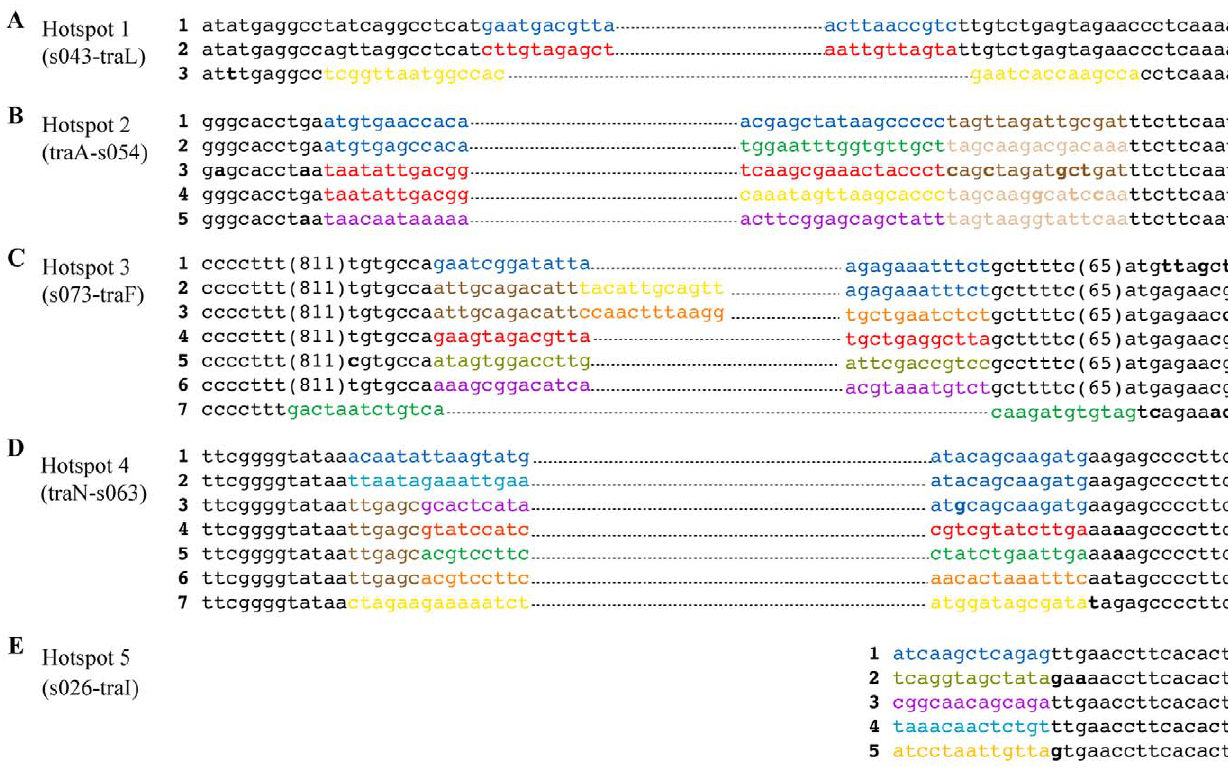
Figure 3. The boundaries of the 5 hotspots. The boundaries between conserved and hotspot variable regions are shown. Black typeface indicates conserved sequence, while color indicates variable sequence. Numbers in parentheses indicate the number of intervening nucleotides. The thin dotted lines indicate continuations of variable DNA. Bold letters indicate a non-conserved base. (A) Hotspot 1, which is present between traJ and traL . Line 1: SXT, ICE Vch Ind4, ICE Pal Ban1; Line 2: R391, ICE Pda Spa1, ICE Vch Ban5, ICE Vch Ind5, ICE Pmi USA, ICE Spu PO1, ICE Vfl Ind, ICE Vch Moz10, ICE Vch Ban9; Line 3: ICE Vch Mex1. (B) Hotspot 2, which is present between traA and s054 . Line 1: SXT, ICE Vch Ind4, ICE Pmi USA, ICE Vfl Ind, ICE Vch Ind5, ICE Pal Ban1, ICE Vch Ban5; Line 2: ICE Pda Spa1, ICE Vch Moz10, ICE Vch Ban9; Line 3: R391; Line 4: ICE Vch Mex1; Line 5: ICE Spu PO1. (C) Hotspot 3, which is present between s073 and traF . Line 1: SXT, ICE Vch Ind4; Line 2: ICE Vch Mex1, ICE Vfl Ind; Line 3: ICE Vch Moz10, ICE Vch Ban9, ICE Vch Ind5, ICE Pal Ban1, ICE Vch Ban5. Line 4: R391; Line 5: ICE Pmi USA; Line 6: ICE Spu PO1; Line 7: ICE Pda Spa1. (D) Hotspot 4, which is present between traN and s063 .